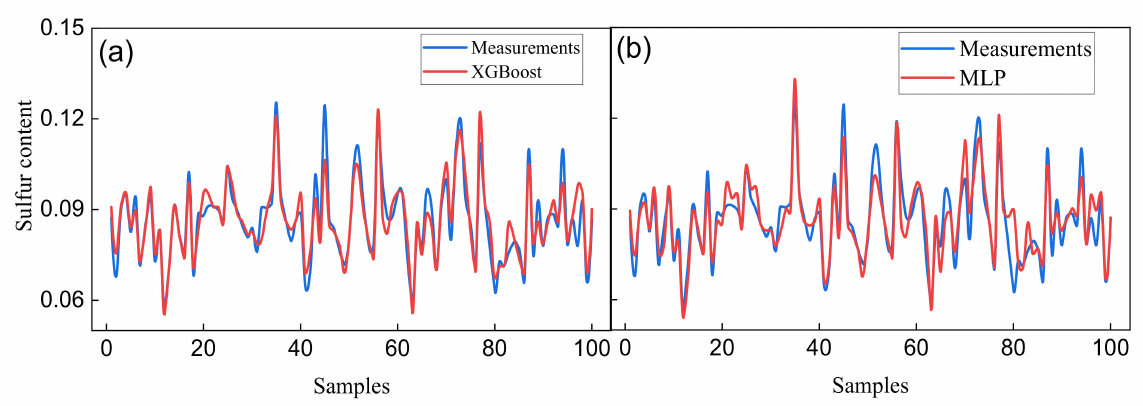
Figure 7. Forecast results of the XGBoost model ( a ) and MLP model ( b